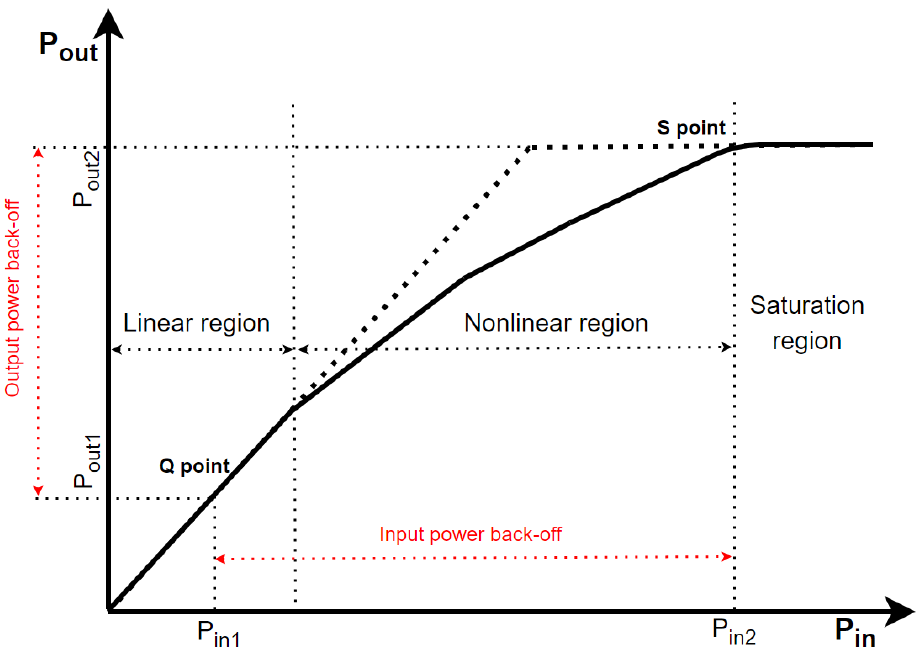
Figure 1. General amplifier transfer characteristic.